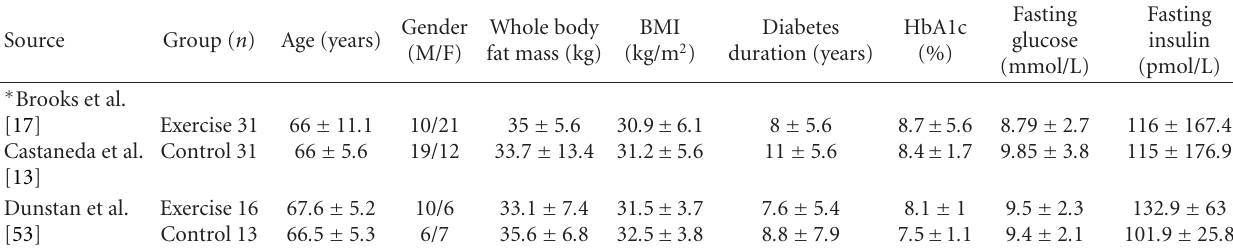
Table 2: Participant